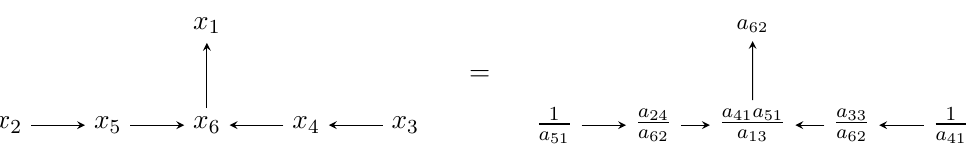
Figure 10. The E 6 -shaped cluster with X -coordinates shown at each of the